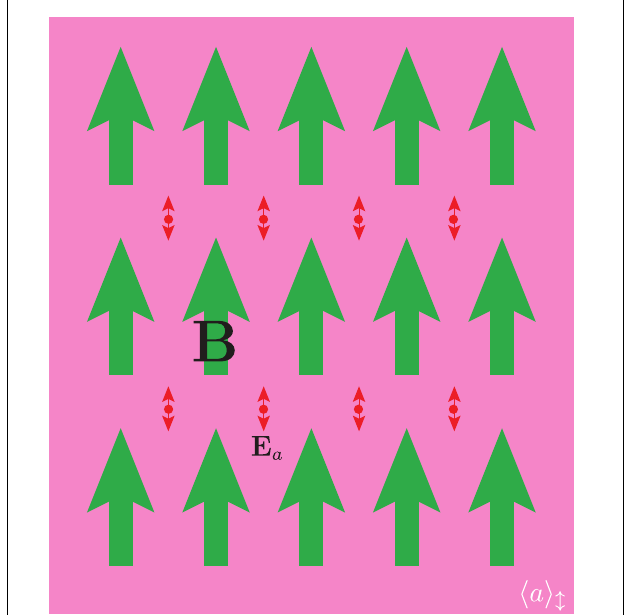
FIGURE 3 | The magnetic and electric field behavior used in the axion detection experiments. The CP violating effect is ∝ B · E , and the oscillating tiny E over the constant large B is schematically drawn. The E follows the oscillation of the classical axion field (cid:5) a (cid:6) .